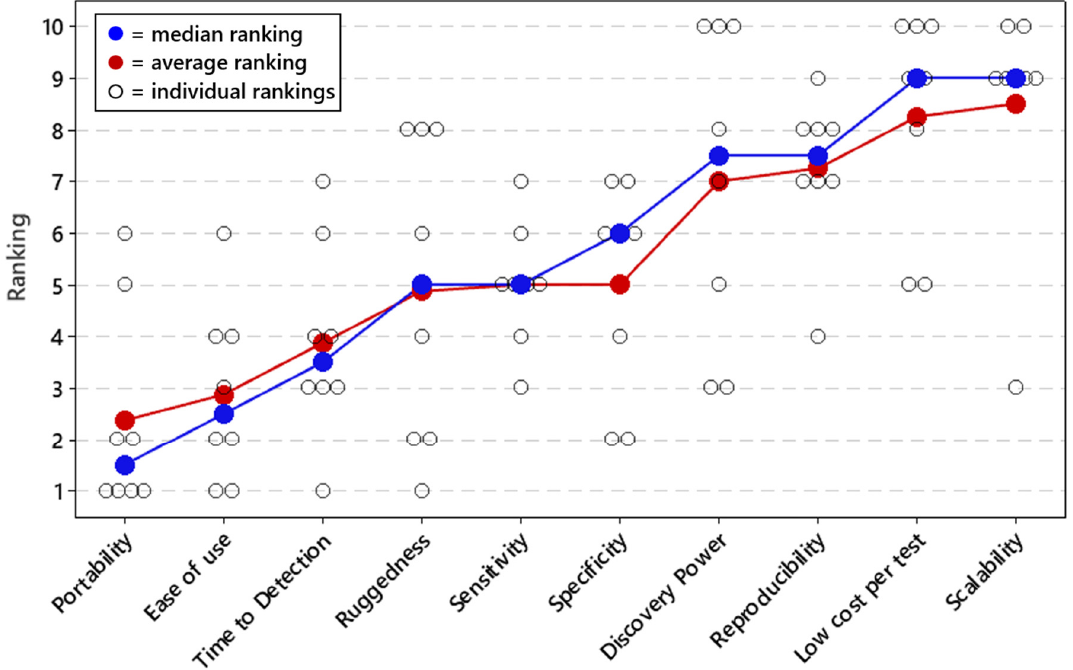
Figure 2. Priorities for field-forward sequencing applications. Respondents ranked all performance metrics on a priority scale of 1 to 10, with 1 being the most important metric and 10 being the least important. The average and median rankings for each performance metric are provided in Figure 2, as well as each individual response. Average and median rankings are based on responses from n = 8